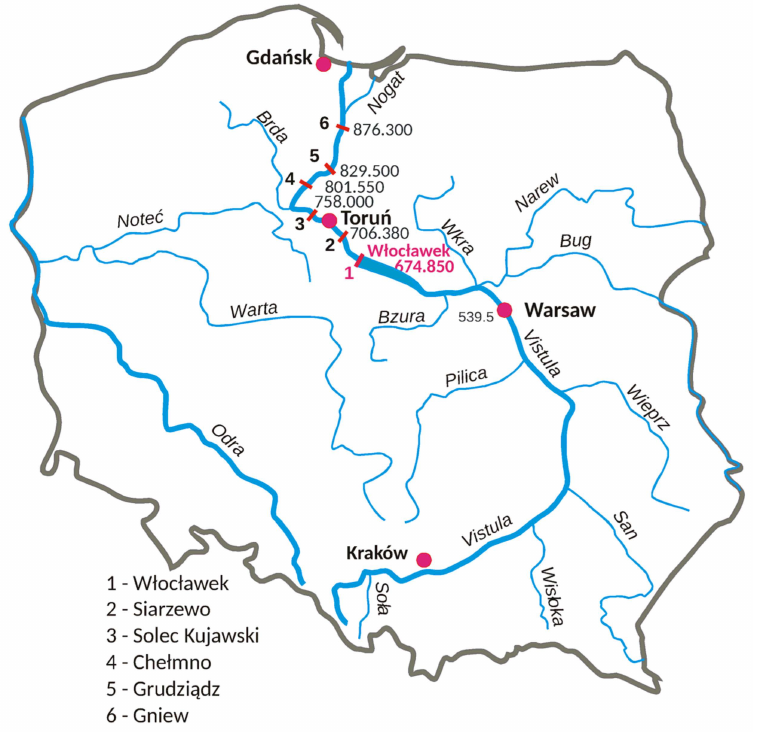
Figure 1. Location of the Włoclawek Barrage and proposed locations for further barrages (from